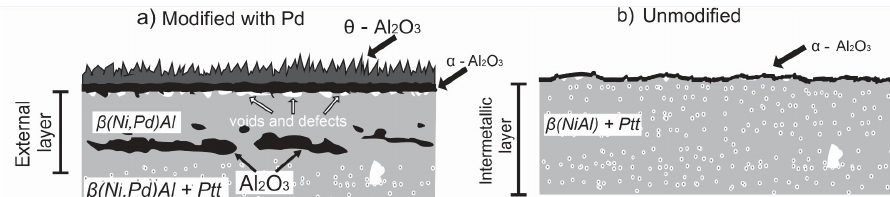
Figure 11. External layer of aluminized coatings after isothermal oxidation at 1000 °C for 200 h: a) Pd-modified; b)